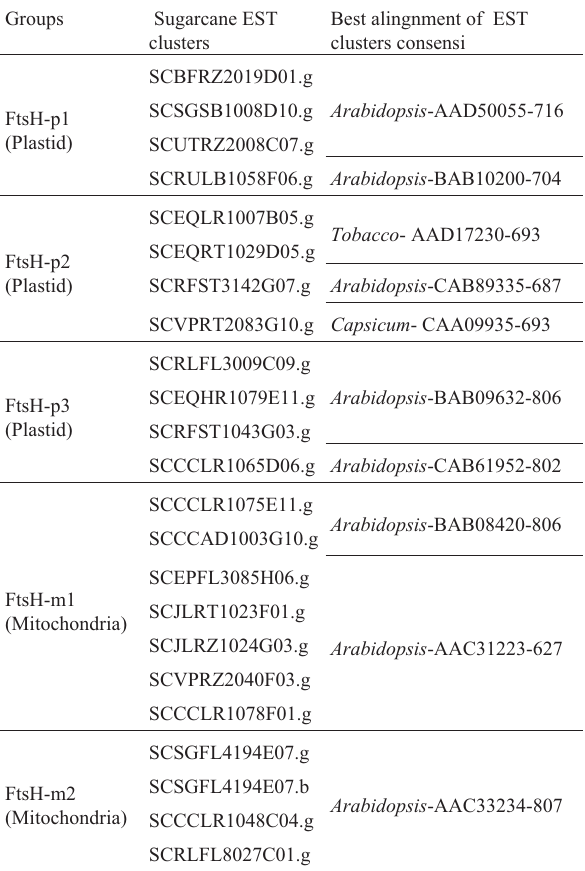
Table II - Phylogenetic profile from FtsH-like proteins Sugarcane EST clusters. Groups Sugarcane EST